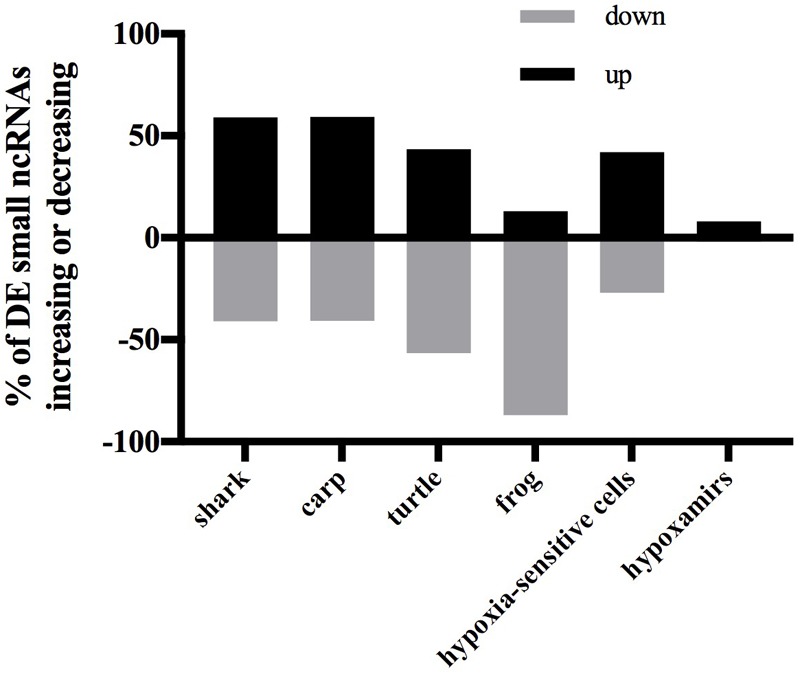
Bar chart showing percent of differentially expressed small ncRNAs that increase or decrease in response to anoxia. Black bars indicate an increase in expression from normoxia to anoxia and gray bars indicate a decrease in expression from normoxia to anoxia. Data for anoxia sensitive cells are from Kulshreshtha et al. (2008) and hypoxamirs are from Azzouzi et al. (2015).